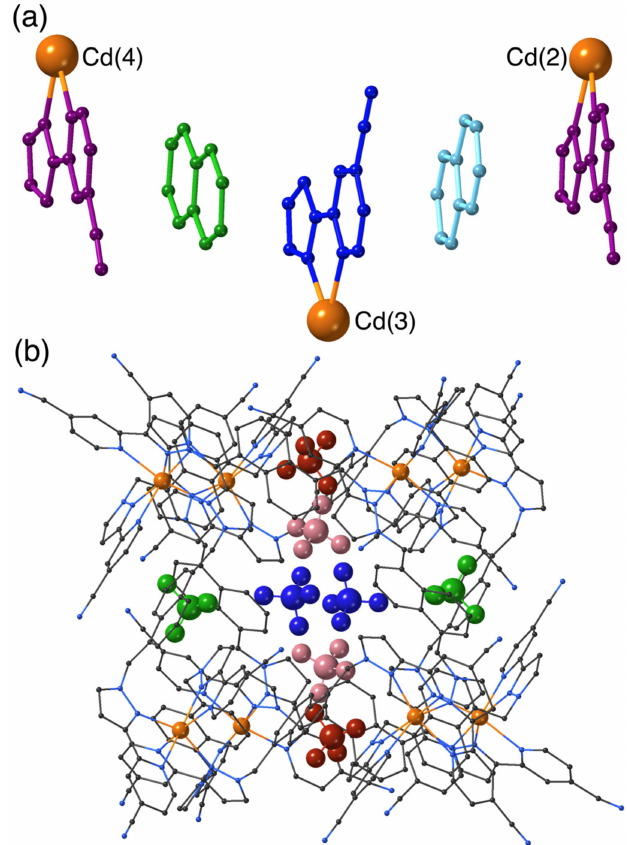
Figure 4. Additional views of the crystal structure of the Cd(II) cage complex Cd • H CN : ( a ) a view of a five-component π -stack between alternating electron-rich and electron-poor ligand fragments; ( b ) wireframe view of the cage showing the location of some of the anions, with symmetry-equivalent pairs coloured the same, embedded in the portals in the cage